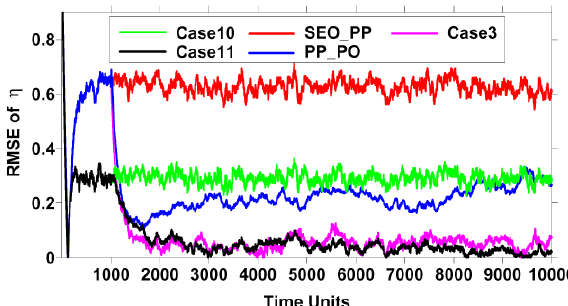
Fig. 10. Time series of RMSEs of η in 10 4 TUs in Case10 (green line) and Case11 (black line). The setups of the two experiments are described in Table 1. Note that the time series of RMSEs of η in SEO_PP (red line), PP_PO (blue line), and Case3 (pink line) are also plotted as